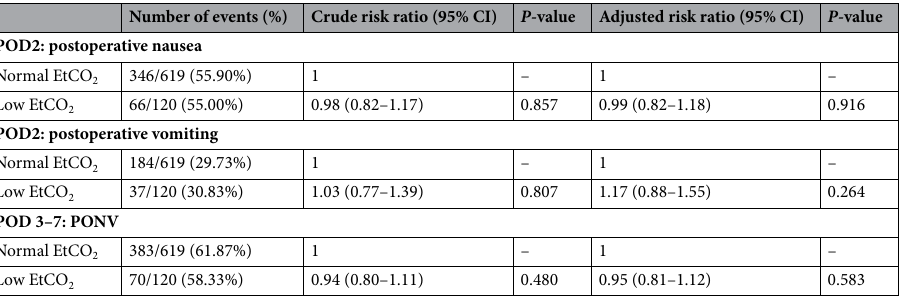
Table 3. Multivariable analysis of the relationship between EtCO 2 and secondary outcomes. EtCO 2 end-tidal carbon dioxide, POD 2 postoperative day 2, POD 3–7 postoperative days 3 to 7, PONV postoperative nausea and vomiting, CI confidence interval.